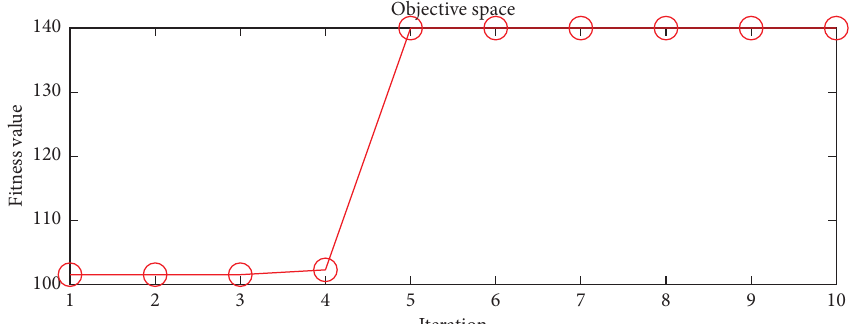
Figure 12: Simulated signals of case 2: PSO convergence curve based on IPAVMD.